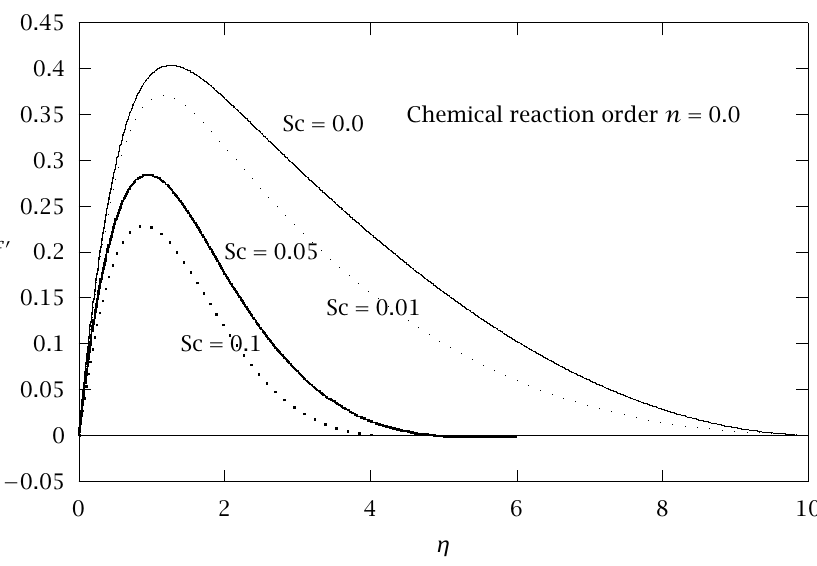
Figure 5.5 . Zeroth order velocity